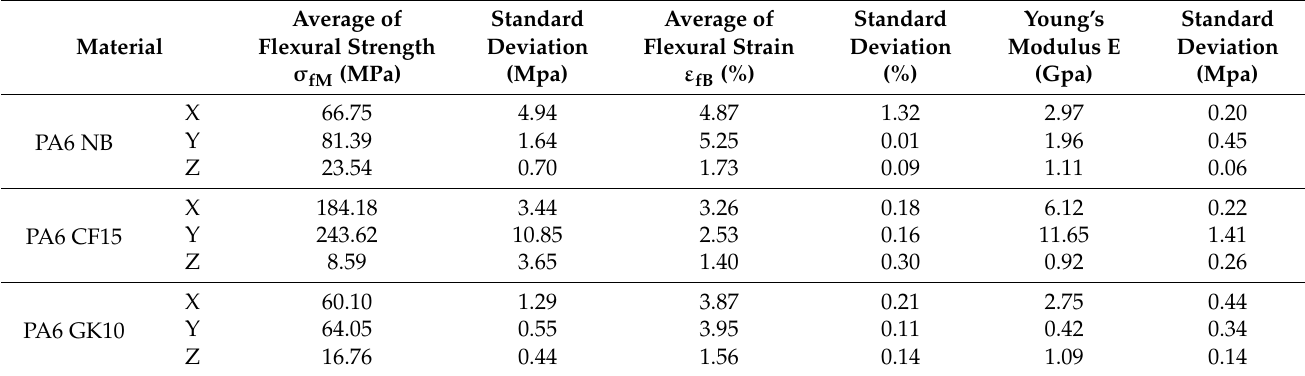
Table 3. Registered bending properties of all tested